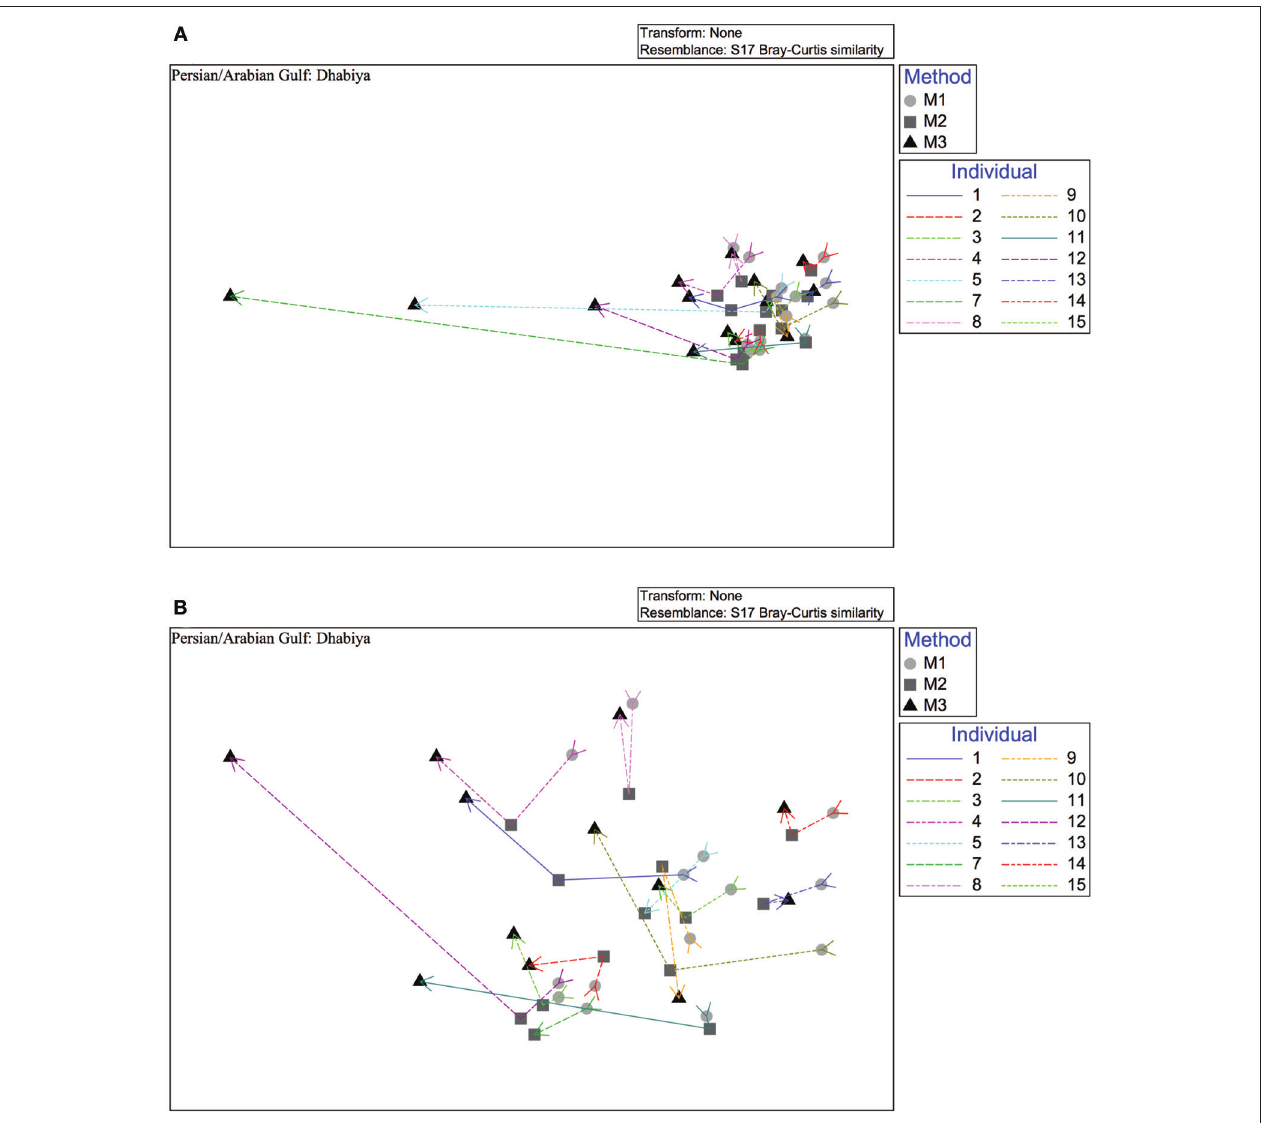
FIGURE 6 | Non-metric multidimensional scaling plot based on Bray-Curtis similarities of the microbial method comparison data depicting Method 1 (circle), Method 2 (square), and Method 3 (triangle). Lines connect individual urchin samples. The upper plot (A) consists of all samples within the Persian/Arabian Gulf site, Dhabiya, while the lower plot (B) does not contain the two outliers (Sample ID: DH7, DH5) for a more in-depth